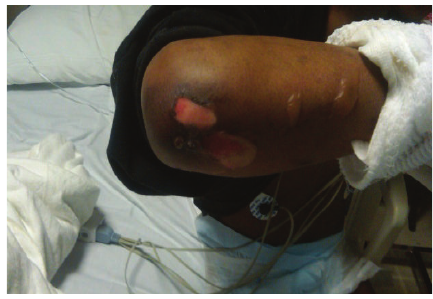
Figure 2: Skin ulceration due to bullae rupture at the right elbow.